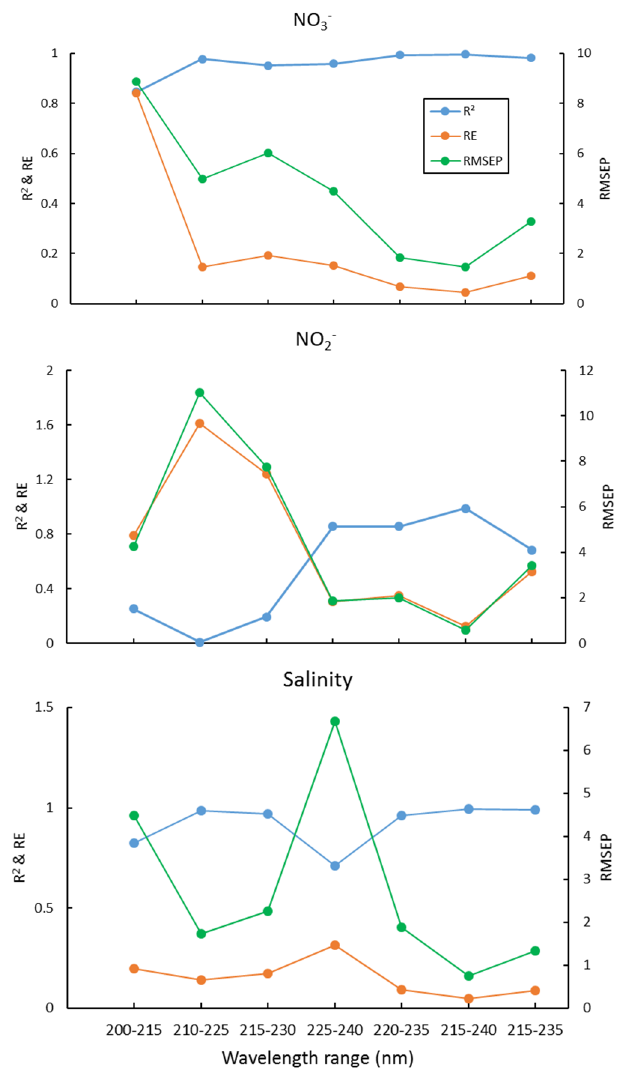
− , NO − , and salinity for different wavelength 3 2